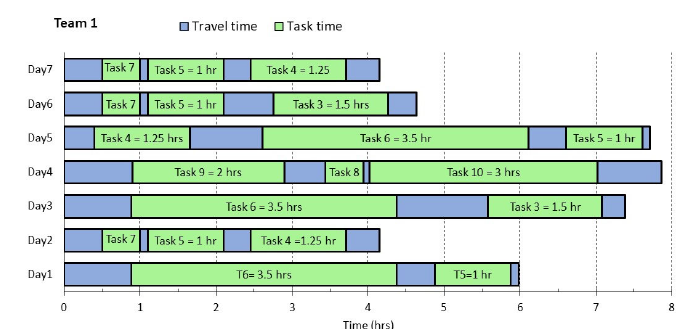
Fig. 5- a . The schedule of team 1 at a speed of 5 km/hr (efficiency